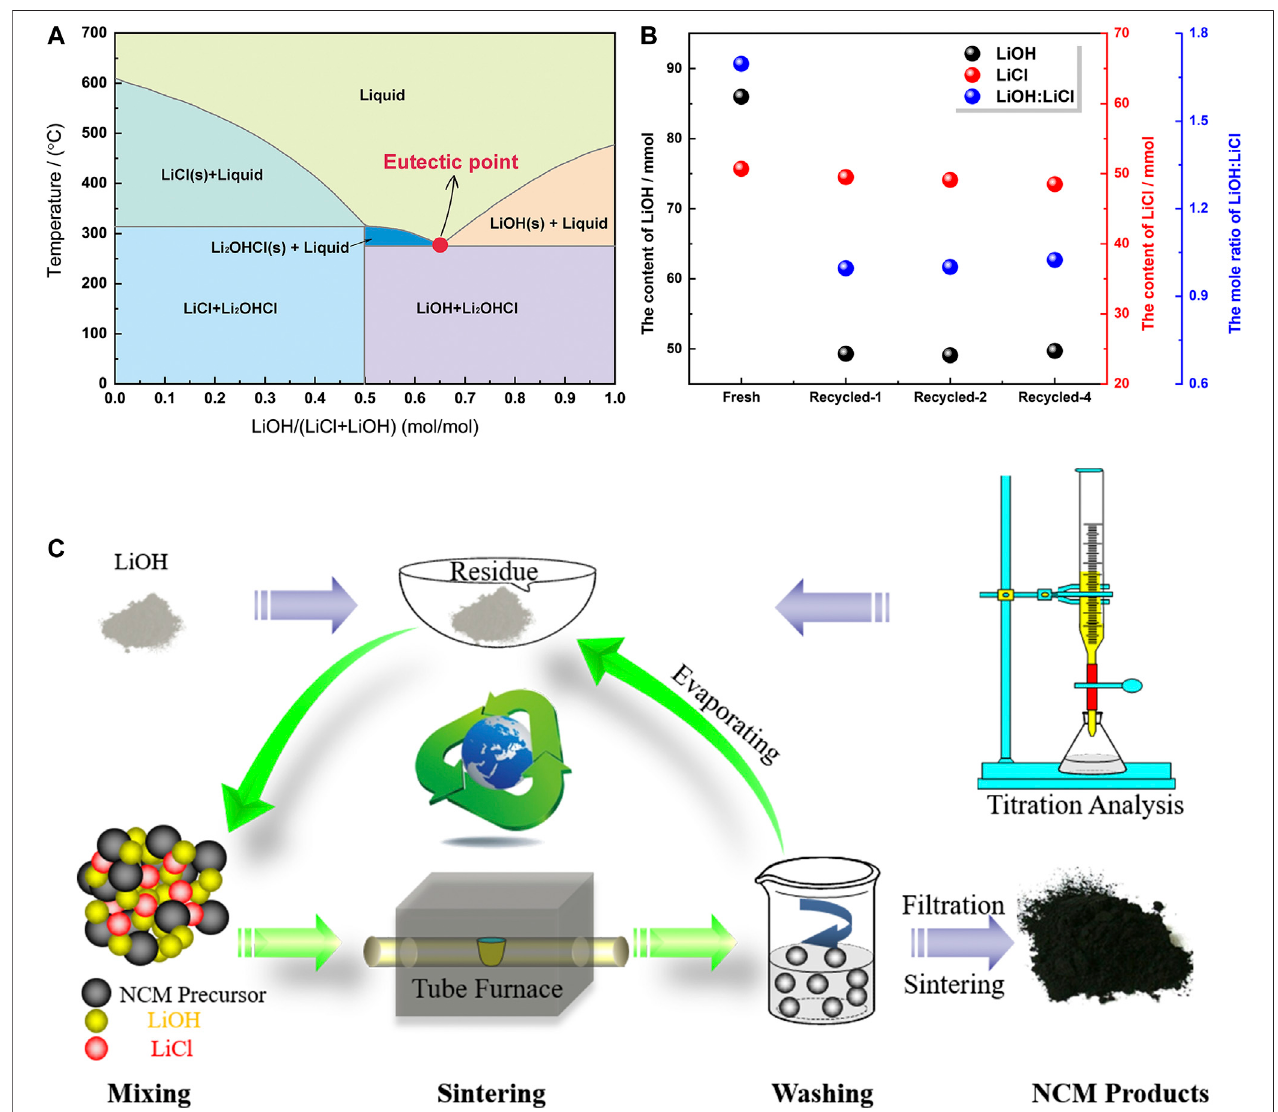
FIGURE 1 | (A) Phase diagram of LiOH and LiCl (reproduced from FACT salt database) (Bianchini et al., 2019). (B) . the amount of substances (LiOH, LiCl) and the calculated mole ratio of LiOH:LiCl in the fresh molten salts and water-washed solutions from NCM materials, which were determined by titrimetric analysis. A nomenclature of Recycled- n ( n (cid:1) 1,2,3 ... ) is used to differentiate the solutions, while Recycled-1 is the solution from NCM-P, Recycled-2 from NCM-1, and so on . (C) . Schematic illustration of “ closed-loop utilization of molten salts ” process during NCM synthesis.